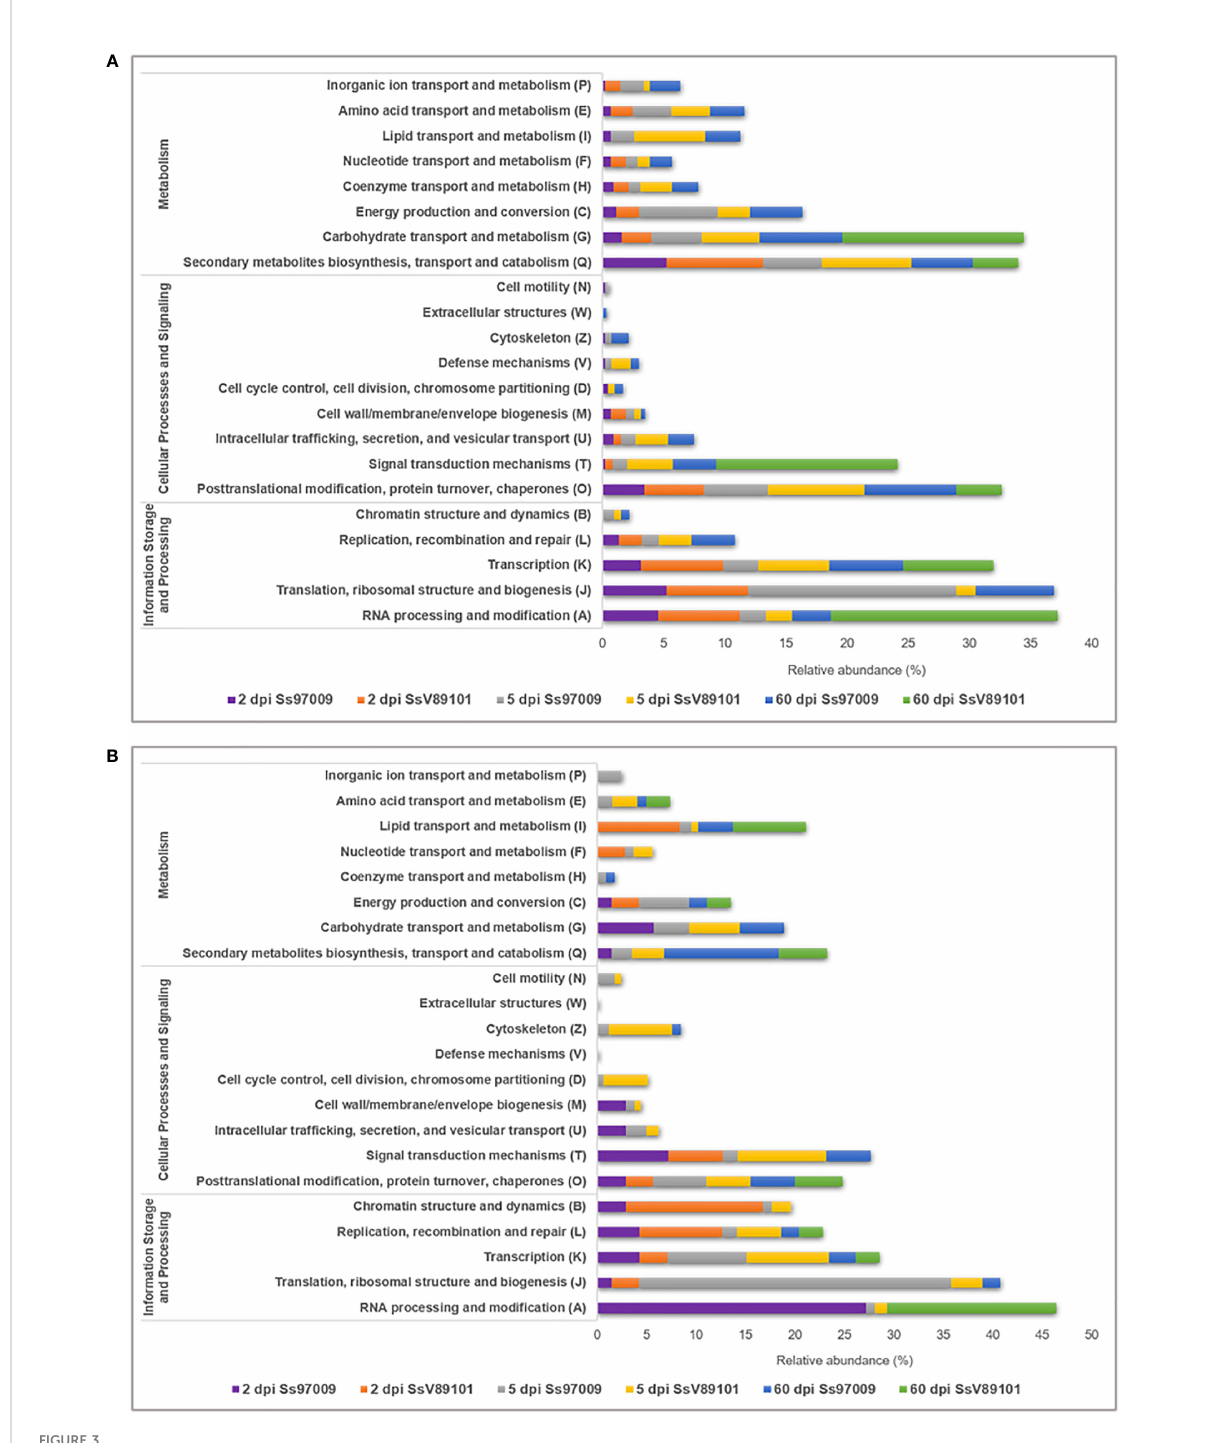
FIGURE 3 Functional distribution of Orthologous groups of proteins (COG) annotation of the differentially expressed genes in sugarcane inoculated with the S. scitamineum isolates Ss97009 and SsV89101. Distribution of COG categories in (A) up-regulated and (B) down-regulated DEGs. The x- axis represents the relative abundance (%) and the y-axis represents the COG